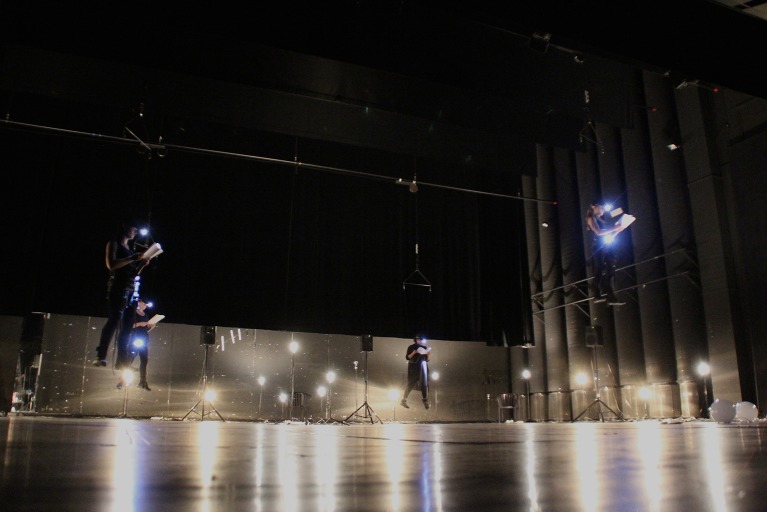
An illustration of the performance piece Metamorphoses (Einarsson, 2015a), a mixed work composed and co-performed by the first author (Einarsson, in press; see also https://vimeo.com/153345880 for a Vimeo video).